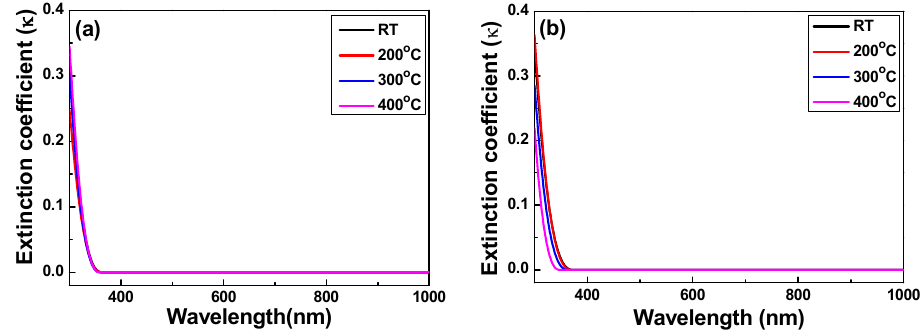
Figure 7. Measured extinction coefficient of Nb 2 O 5 thin films as a function of deposition temperature and O 2 ratio. ( a ) O 2 ratio 10% and ( b ) O 2 ratio 20%, respectively.